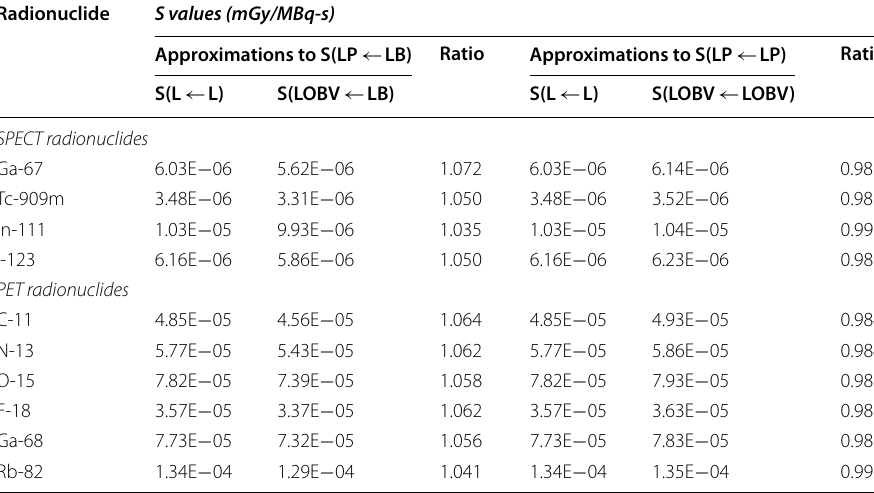
Table 5 Approximations of S ( LP ← LB ) and S ( LP ← LP ) values for 10 radionuclides with applications to diagnostic imaging using the single‑region and dual‑region tetrahedral mesh models of the reference adult female liver